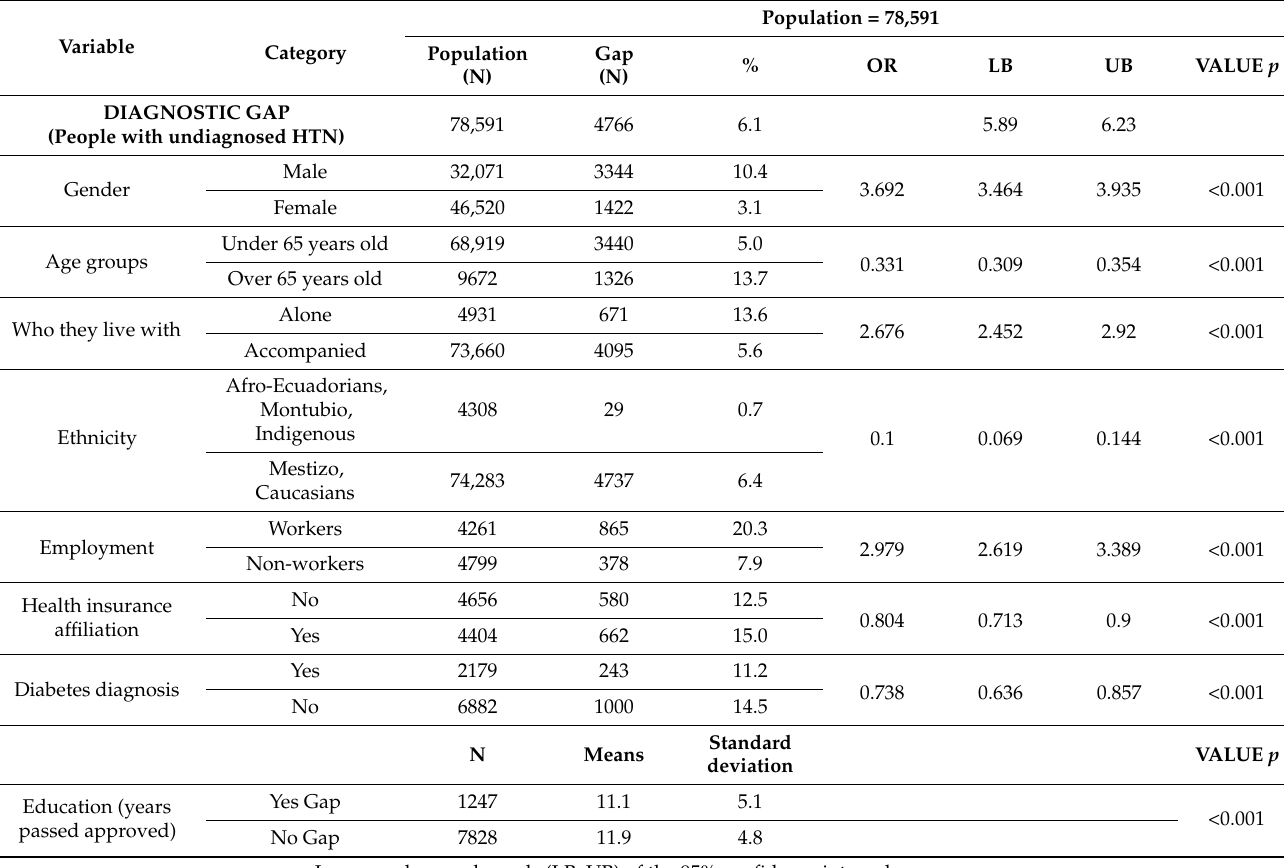
Table 2. Associated Factors to the Diagnostic Gap.